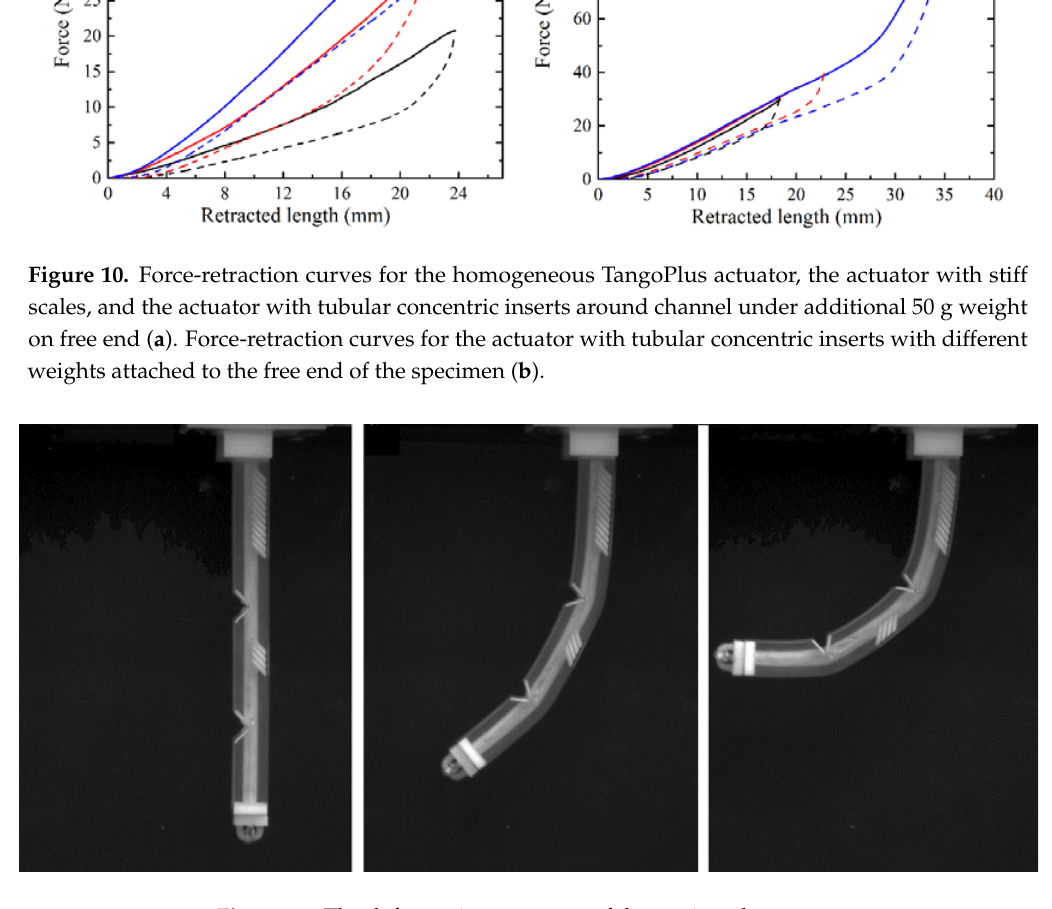
Figure 11. The deformation sequence of the sectioned actuator.